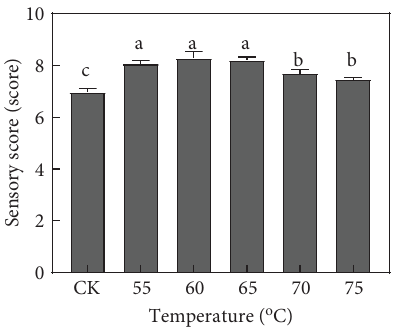
Figure 1: Sensory scores of “Yali” pear paste prepared under traditional heating concentration and vacuum concentration with diferent temperatures. CK: pear paste under traditional heating concentration; 55 ° C, 60 ° C, 65 ° C, 70 ° C, and 75 ° C: pear paste at diferent vacuum concentration temperatures; diferent letters indicated signifcant diferences among groups ( p < 0 .